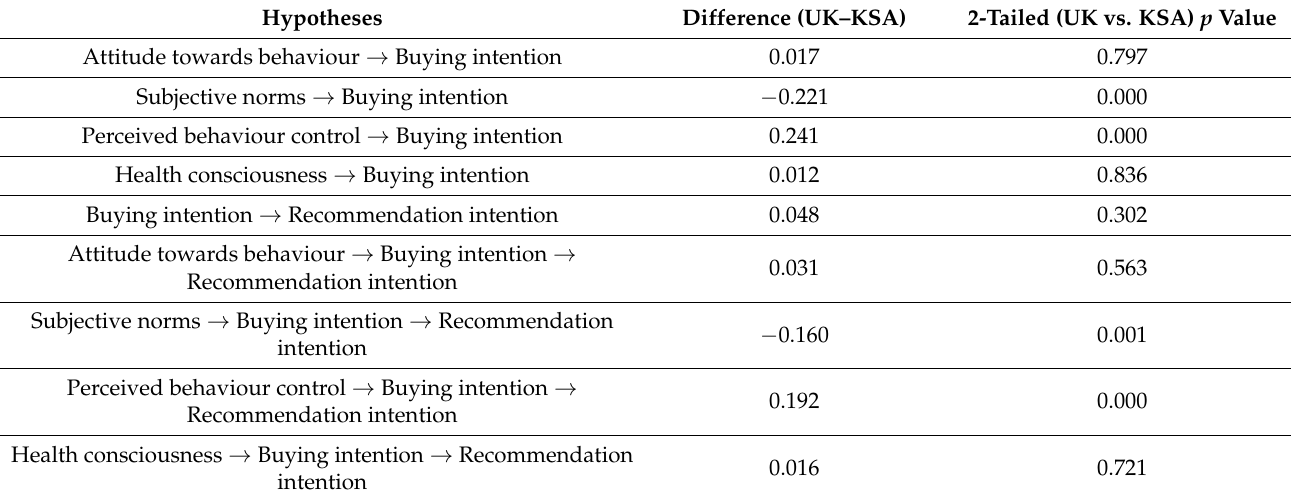
Table 6. Multi-group